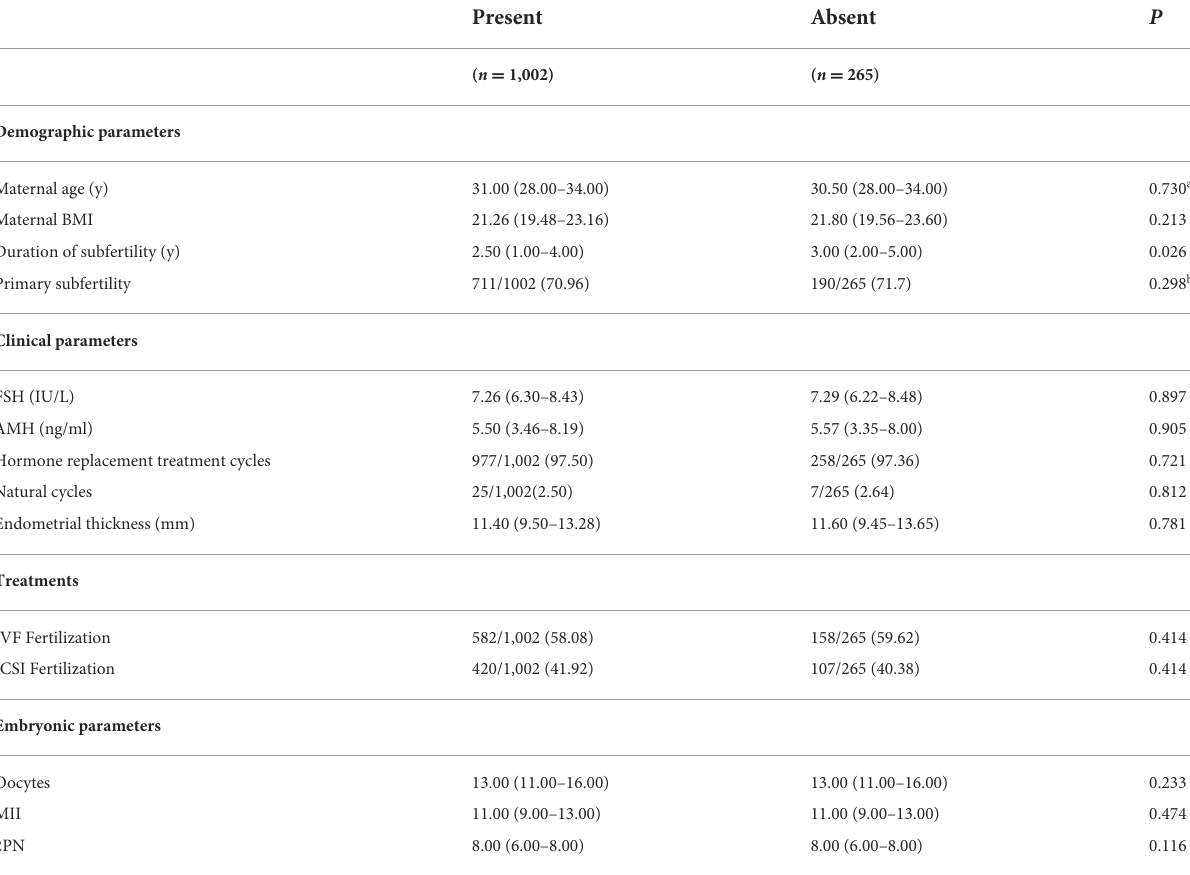
TABLE 1 Baseline demographic features of the included patients and